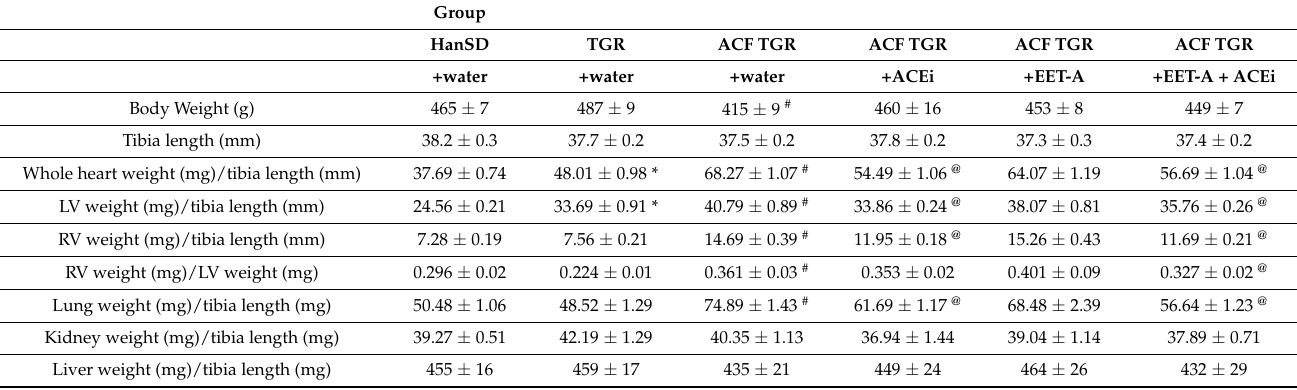
Table 2. Body and organ weights 4 weeks after creation of the aorto-caval fistula (ACF) or sham-operation and after 2 weeks’ treatment with 14,15-epoxyeicosatrienoic acids analog (EET-A) and angiotensin-converting enzyme inhibitor (ACEi), alone or combined with EET-A.